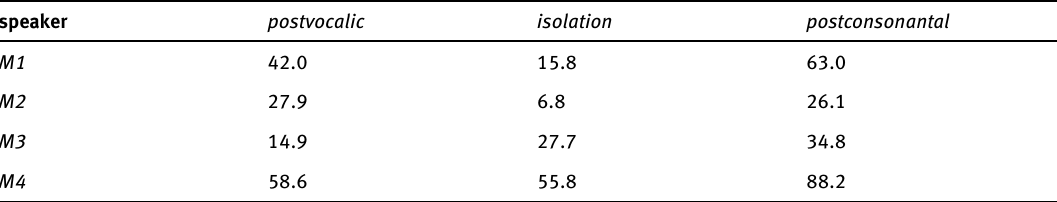
Table 4: Mean rate of prothesis (percentage) by participant and